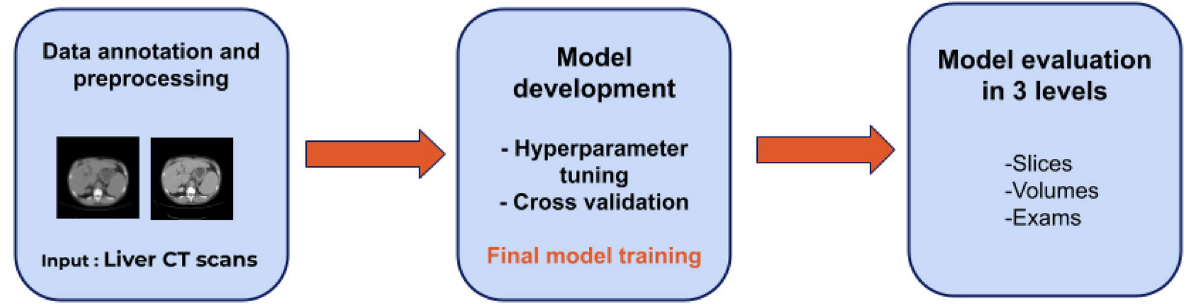
Figure 1. Overview of the methodology and application. Our methodology is divided into three main steps: (1) data annotation and preprocessing, (2) model development and (3) model